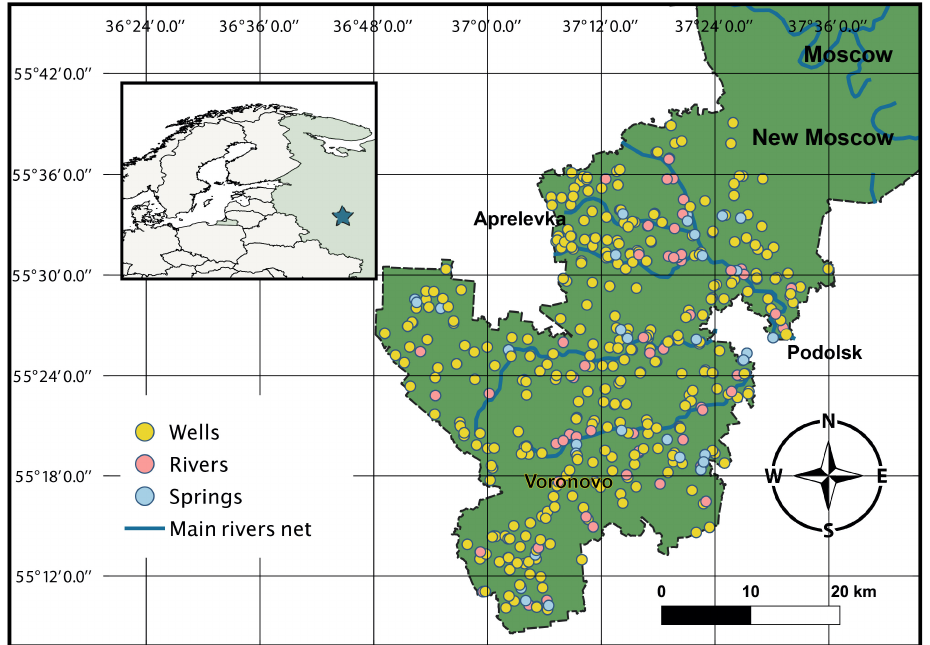
Figure 1. Location map of the study area. Different colors mark source of collected water samples— wells colored in yellow; rivers colored in pink; and springs colored in blue. Blue lines represent main river streams from open-source 10-m resolution